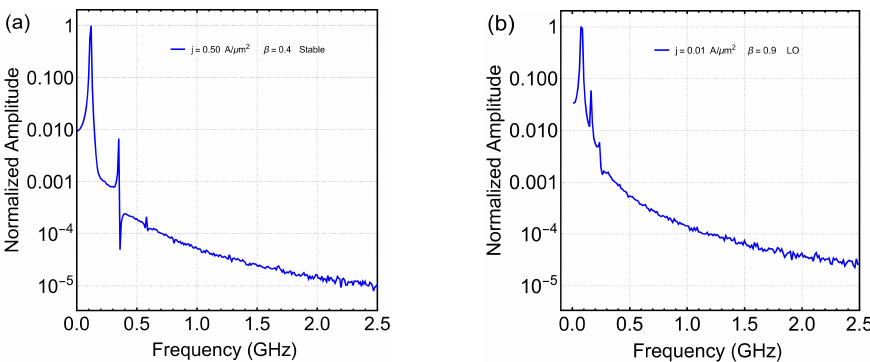
Figure 6. Fast Fourier Transform of the z-component of magnetization spatial average, (cid:104) M z (cid:105) , as a function of the frequency at ( J , β ) = ( 0.5 A/ µ m 2 ,0.4 ) ( a ) and ( J , β ) = ( 0.01 A/ µ m 2 ,0.9 ) ( b ). Here, panel ( a ) represents a global oscillation, while panel ( b ) represents a local